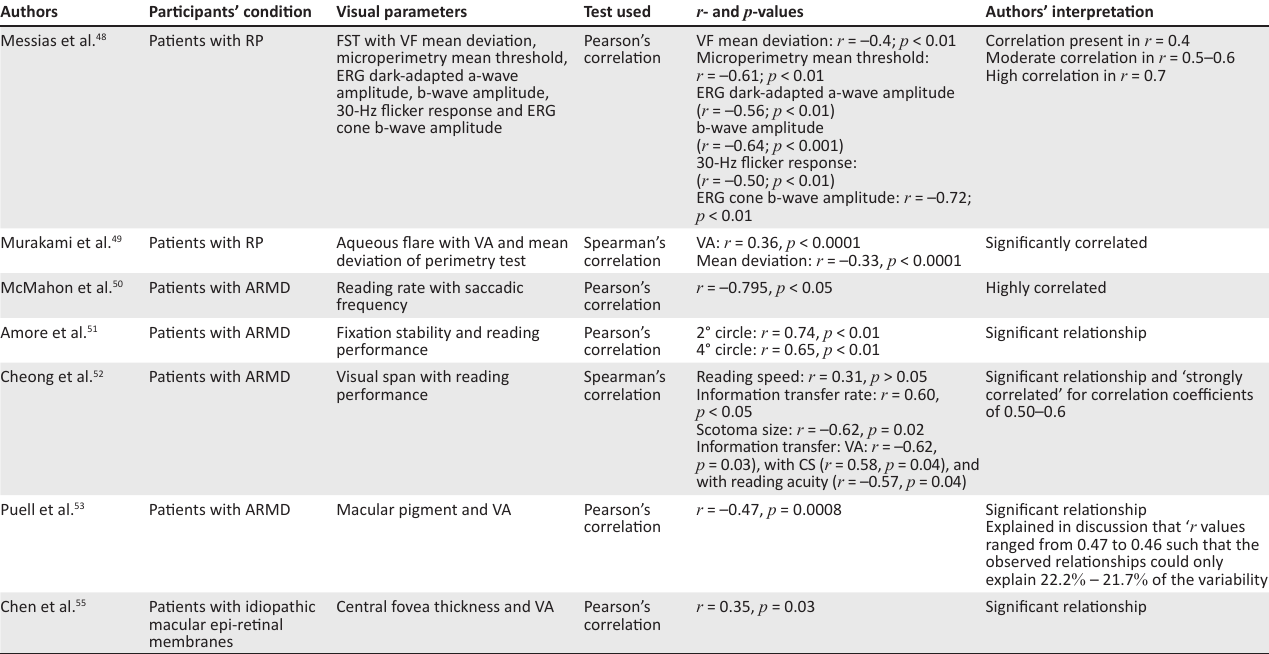
TABLE 3: Studies targeting patients with low vision using both Pearson’s and Spearman’s correlation coefficient tests. Authors Participants’ condition Visual